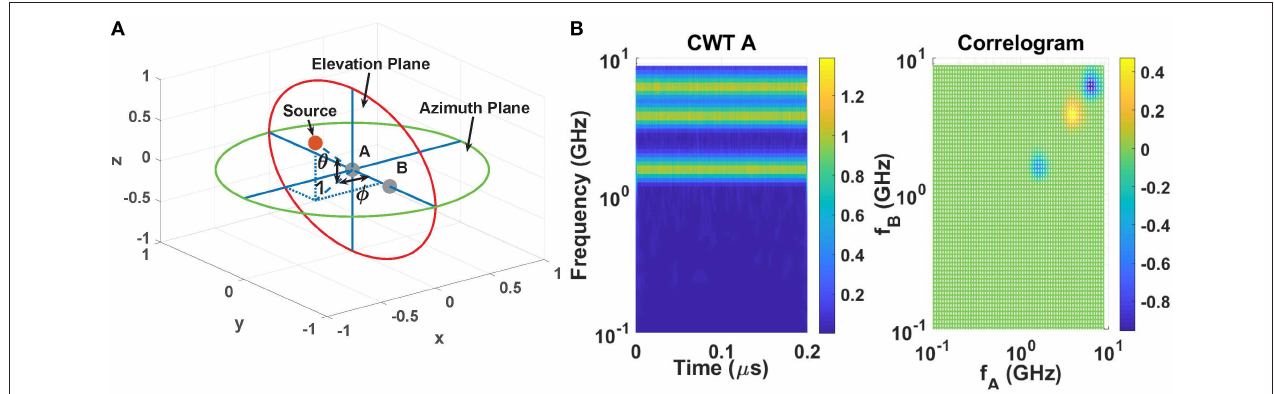
FIGURE 2 | (A) Geometry for 2D far-field source localization. (B) Continuous wavelet transform (CWT) of signal at sensor A (tones at 6.3, 3.9, and 1.6 GHz) (left), and the cross-correlogram (right) generated by correlating it with the CWT of signal at sensor B (same frequencies, but with phase shifts of π , − π/ 3, and 2 π/ 3 rad,